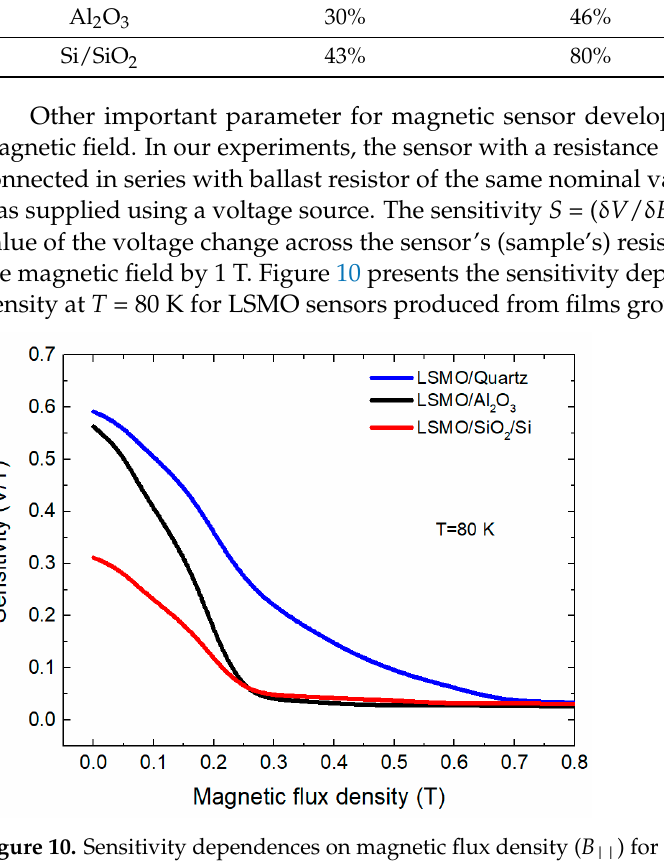
Figure 10. Sensitivity dependences on magnetic flux density ( B || ) for LSMO sensors produced from films grown on different substrates. Measured using voltage supply of V s = 2.5 V.